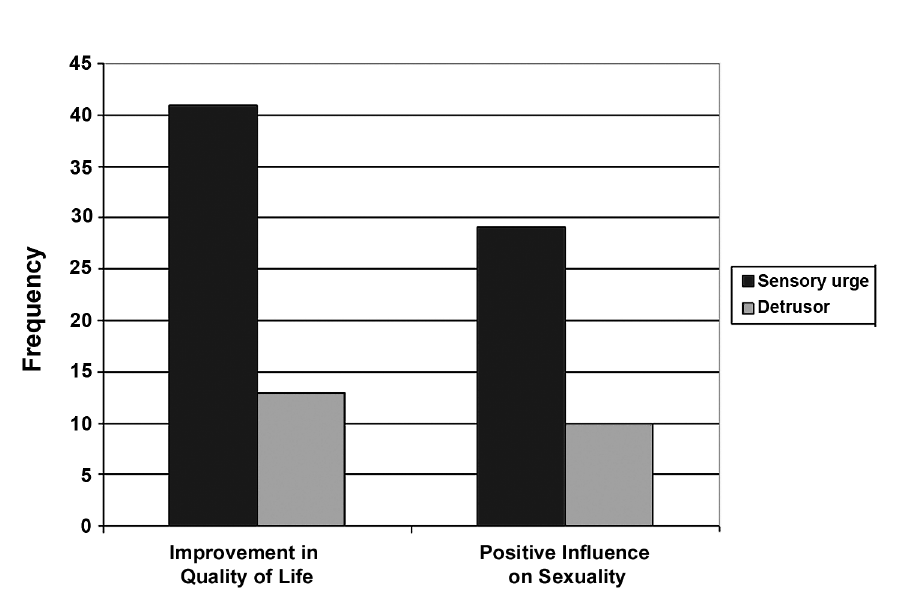
Figure 3 – Post-therapeutic quality of life and sexuality in group A (sensory urge) and group B (detrusor overactivity). Significant improvement in quality of life was